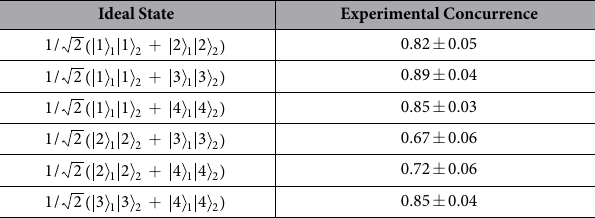
Table 1. Two-qubit concurrences in the two-dimensional